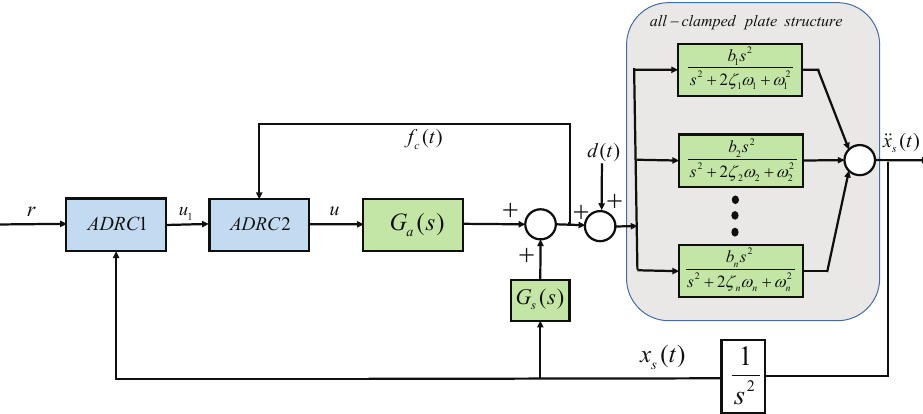
Figure 3. Schematic representation of the cascade ADRC control